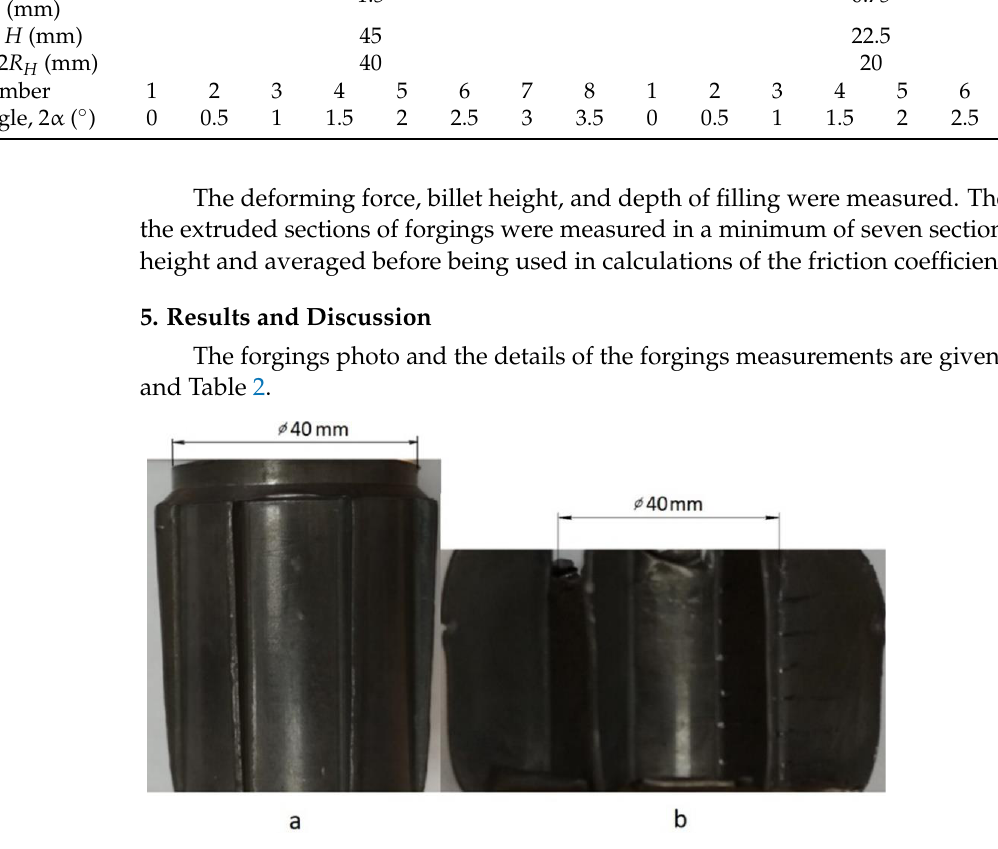
Figure 8. Photo of the forgings at the initial ( a ) and final ( b ) stages of deformation. Table 2. Average (Av.) lengths of radial elements of forgings with different dimension ratios (DRs) under different friction conditions (with and without lubrication).